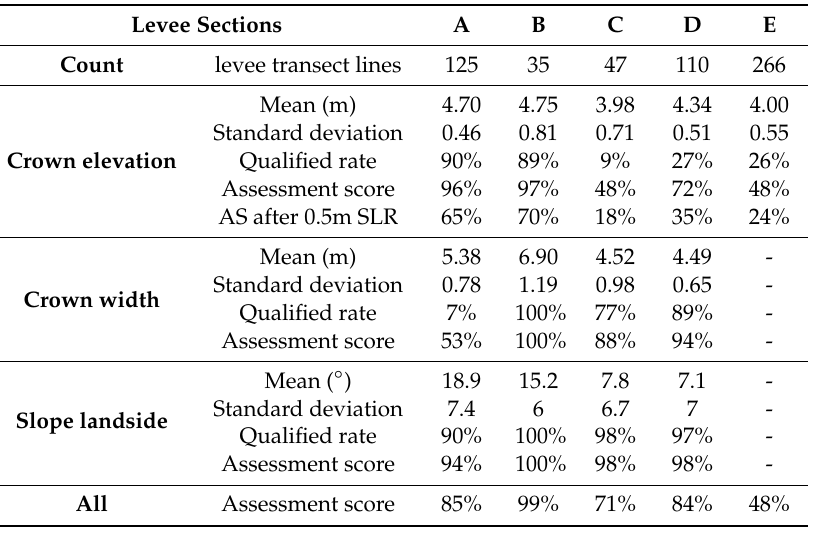
Table 3. Statistic of levee geometric parameters and assessment results. The qualified rate is defined as the count percentage that each parameter meets the designed standards. The assessment score (AS) is normalized into percentage by comparing the actual scores to the full scores for each and all four parameters within each levee segment. A 0.5 m Sea Level Rise (SLR) is also